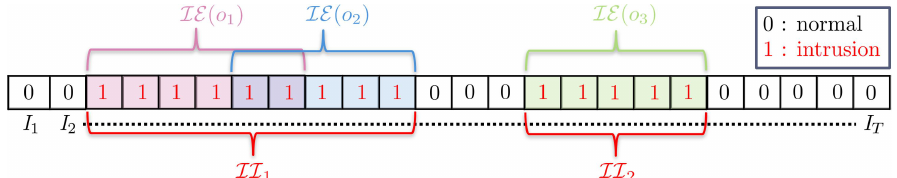
Figure 6. Illustration of intrusion event of the video and intrusion intervals. Objects o 1 , o 2 and o 3 cause intrusion events IE ( o 1 ) , IE ( o 2 ) and IE ( o 3 ) , marked with value 1. IE ( V ) is collection of all of the frames with value 1. Two intrusion intervals II 1 and II 2 are shown in red